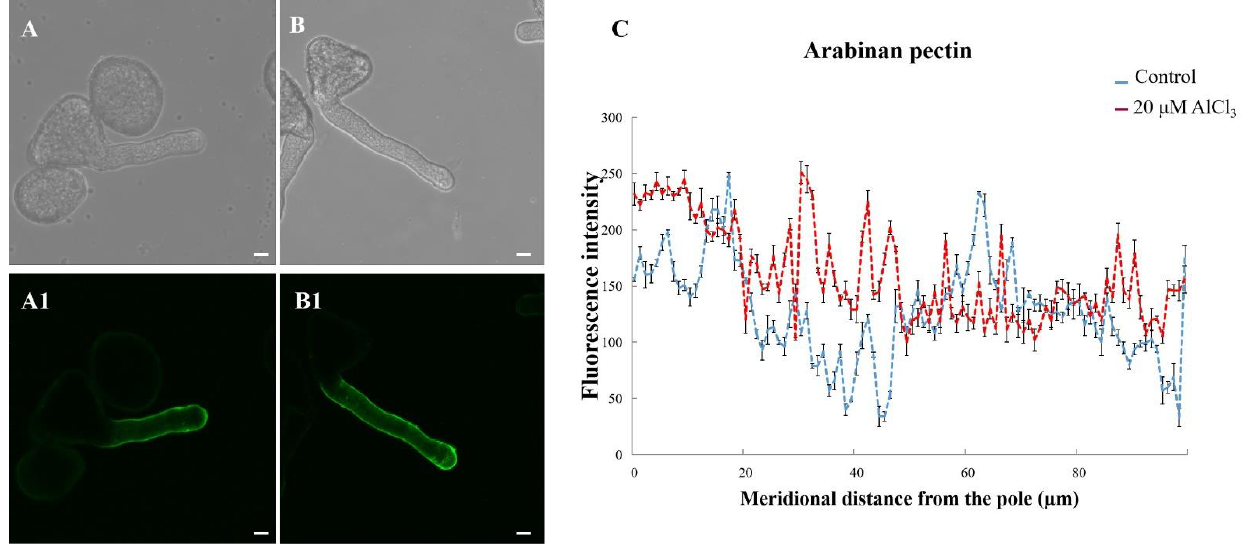
Figure 6. Effect of 20 µM AlCl 3 on the distribution of arabinan pectin in pollen tube wall of M. do- mestica. ( A ) Bright-field image of a control pollen tube. ( A1 ) Arabinan pectin of the pollen tube in A labeled with LM 6 under CLSM. ( B ) Bright- field image of a pollen tube treated with 20 μM AlCl 3. ( B1 ) Arabinan pectin of the pollen tube in B. ( C ) Quantitative analysis of the fluorescent intensity of control (blue line) and 20 µM AlCl 3 treated (red line) pollen tubes. Bar = 10 µm. 2.6. Effects of 20 µM AlCl 3 on Chemical Composition of Pollen Tube Cell Wall of M. domestica The infrared spectrograms of the pollen tube tips were analyzed. The difference spec- trum was made, and the results showed that the spectrum of pollen tube tip changed after 20 µM AlCl 3 treatment (Figure 7). In the spectrum of the cell wall at the tip of the control pollen tubes, the absorption peak of the saturated ester was 1736 cm −1 , while 1623 cm −1 and 1522 cm −1 were the absorption peaks of amide I and amide II, respectively; 1455 cm −1 was the absorption peak of carboxylic acid. The range of 1200-900 cm −1 was the absorption peak of carbohydrate. It could be seen from the Figure 7 that the absorption peak of satu- rated ester rose slightly, which indicated that the esterified pectins in the cell wall at the tip of 20 µM AlCl 3 treated pollen tubes increased. The absorption peak of carboxylic acid decreased, indicating that acid pectins in the tip cell wall of 20 µM AlCl 3 treated pollen tube decreased. The absorption peak intensity of amide I band and amide II band de- creased, and the absorption peak position changed, indicating the protein composition and content in the cell wall changed. The intensity of the carbohydrate absorption peak increased. These results were similar to those of the above-mentioned immunofluores- cence labeling.